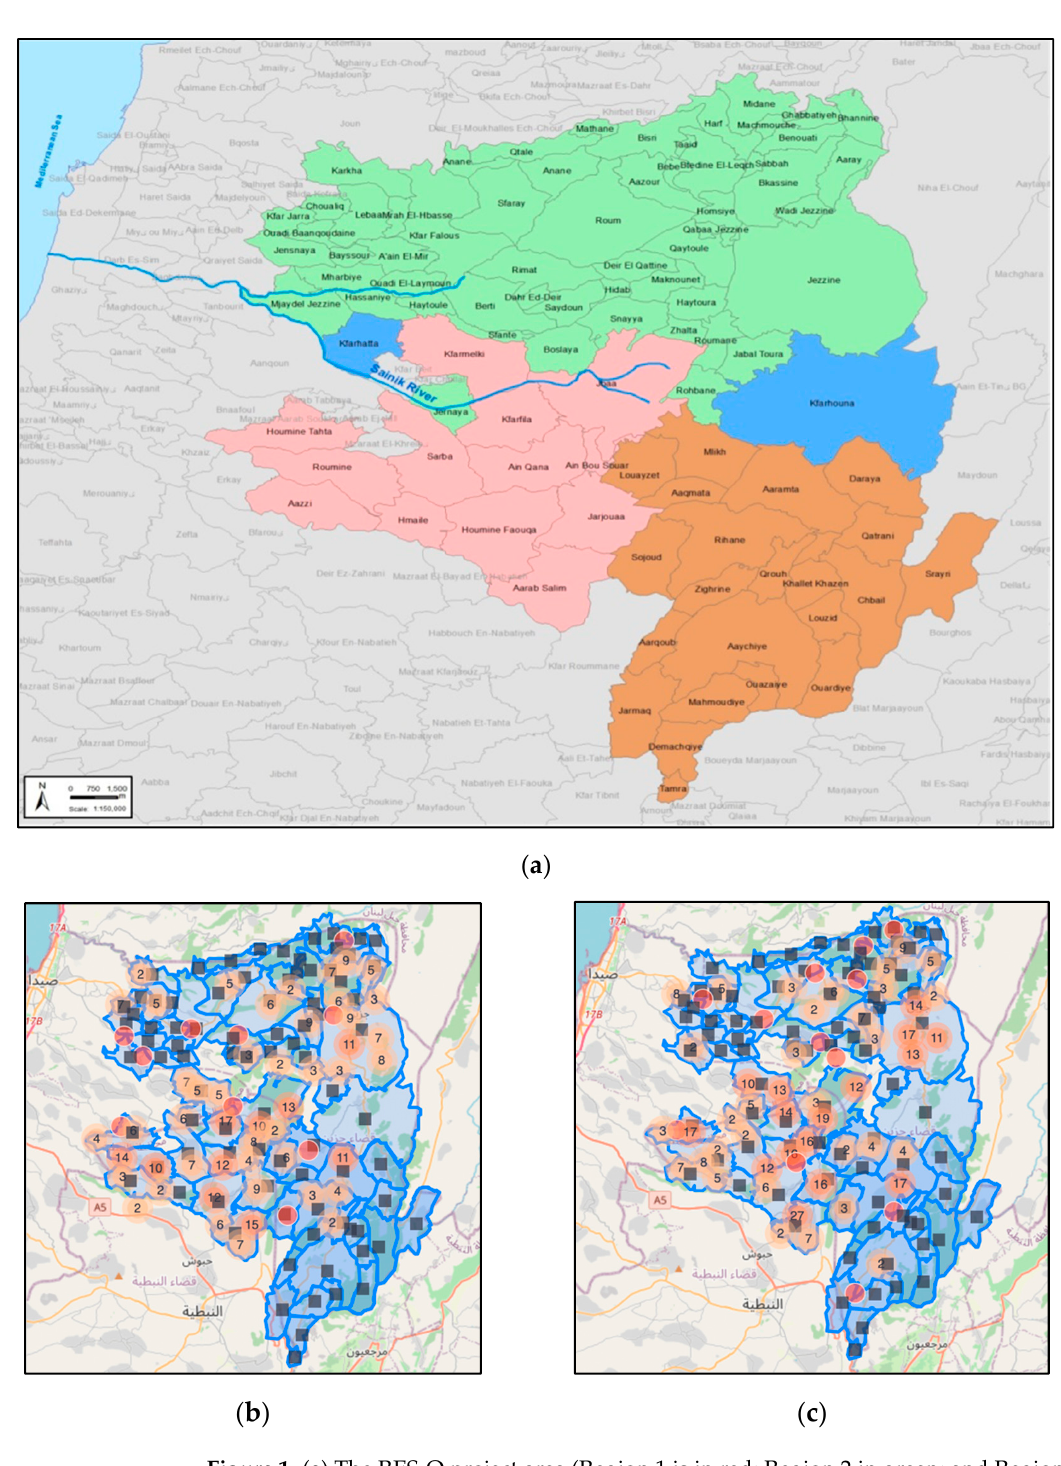
Figure 1. ( a ) The RES-Q project area (Region 1 is in red; Region 2 in green; and Region 3 in brown); ( b ) Kobotoolbox-generated map displaying the first wave of data collected ( n = 380); and ( c ) map displaying the second wave of data collected ( n = 389). The blue areas represent the boundaries of each village in the targeted area. The numbers and dots represent the number of questionnaires collected in each village.